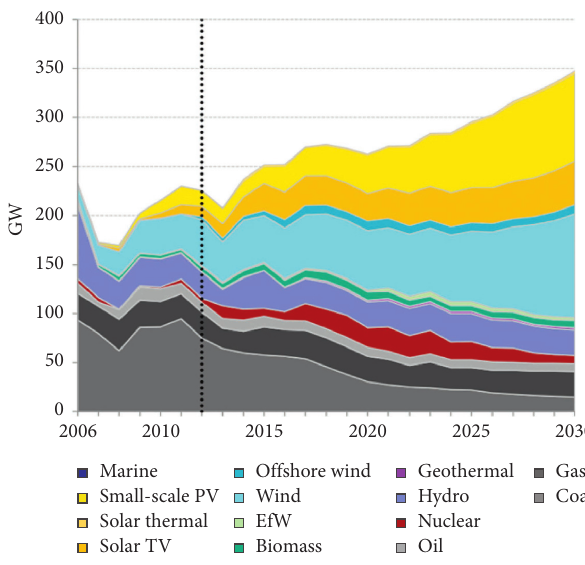
Figure 3: Prediction for most important energies used in the world (predicted successfully till